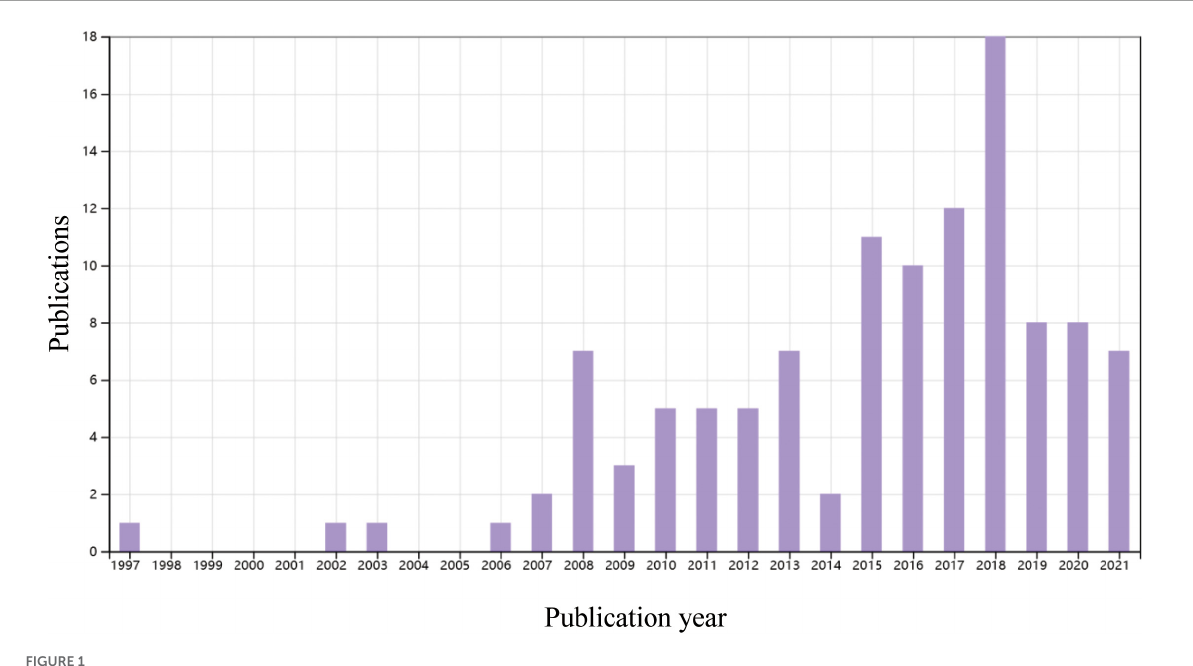
FIGURE1 A time course of publications concerning clinical trials of percutaneous coronary intervention (PCI) or coronary artery bypass graft in patients with coronary chronic total occlusion (CTO). Data source: Web of Science, searched with the topics (CTO or "chronic total occlusion") AND [(PCI or "percutaneous coronary intervention") OR CABG or "coronary artery bypass graft"] and then refined by document types "Clinical Trial" and